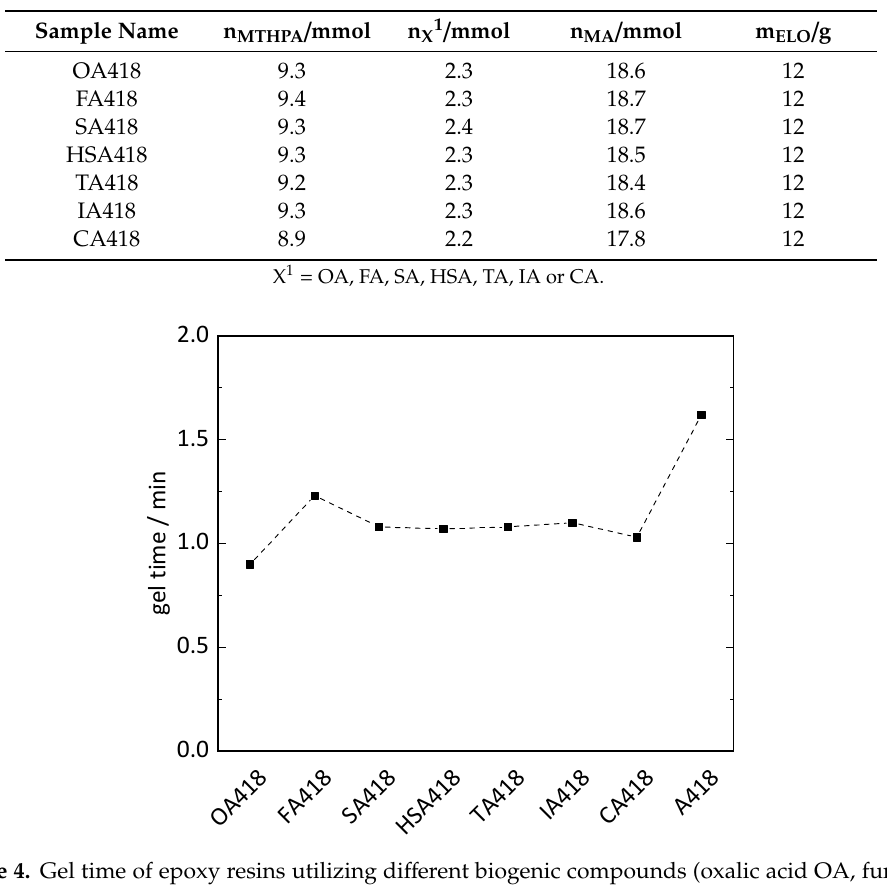
Table 2. Chemical amounts of methyltetrahydrophthalic anhydride (MTHPA) n MTHPA , X 1 n X1 and maleic acid (MA) n MA , and mass of epoxidized linseed oil (ELO) m ELO of the precursors.